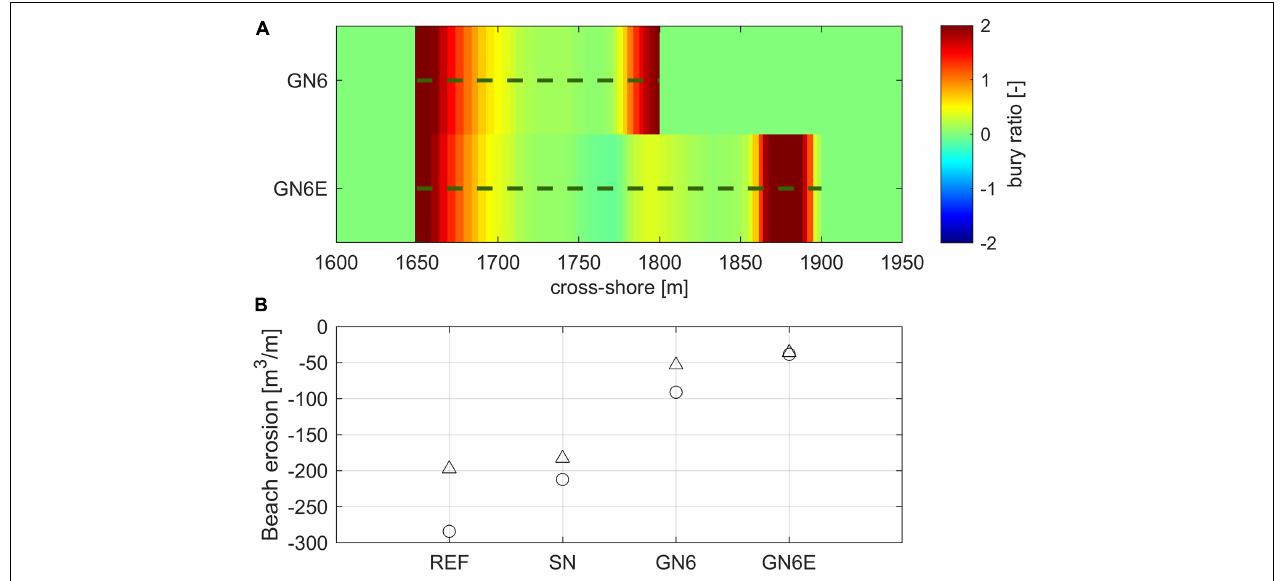
FIGURE 14 | The bury ratio of GN6 and GN6E after the storm are given in panel (A) . The beach erosion of REF, SN, GN6, and GN6E are given in panel (B) by integrating the difference of final seabed profile against pre-storm seabed (triangle) and initial seabed (circle).